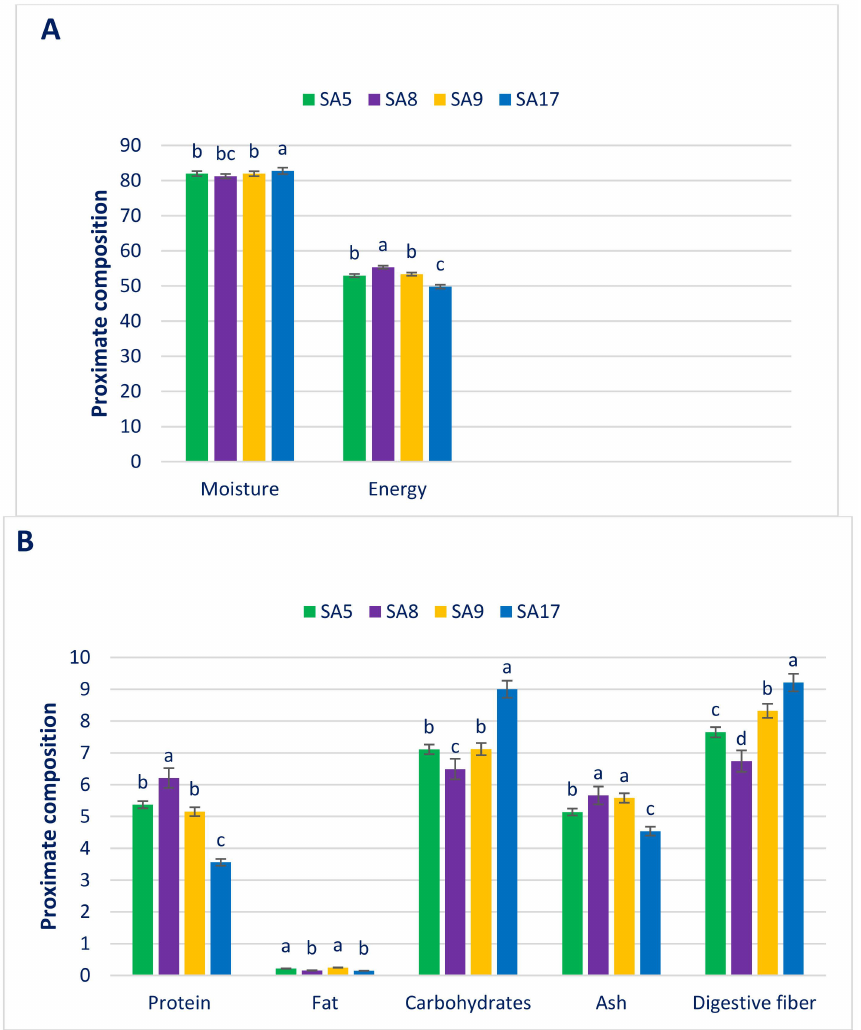
Figure 1. Proximate composition (per 100 g − 1 FW, energy kcal 100 g − 1 FW) in danta leaves. ( A ) Mois- ture and energy, ( B ) Protein, fat, carbohydrates, ash and digestive fiber. Dissimilar letters over the bars indicate that the corresponding data significantly differed by Duncan multiple range test (DMRT) ( p < 0.01, n =